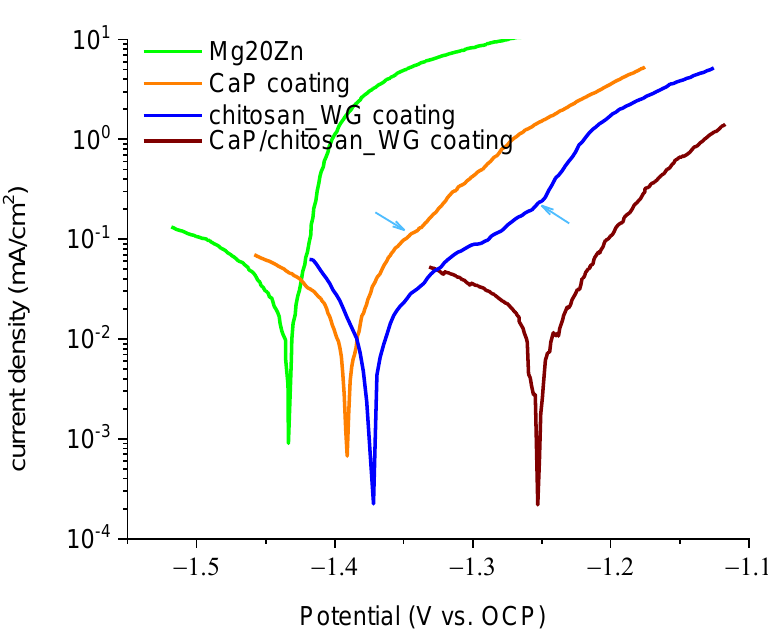
Figure 5. LSV curves (1 mV/s) of the Mg20Zn alloy and the different coatings in the Hank’s solution at 37 °C. Prior to LSV experiments, samples were immersed at the OCP for 30 min (OCP values: −1.47 V vs. Ag/AgCl for the alloy; −1.41 V vs. Ag/AgCl for Ca-P; −1.37 V vs. Ag/AgCl for Chitosan_WG, and −1.32 V vs. Ag/AgCl for CaP/chitosan_WG).